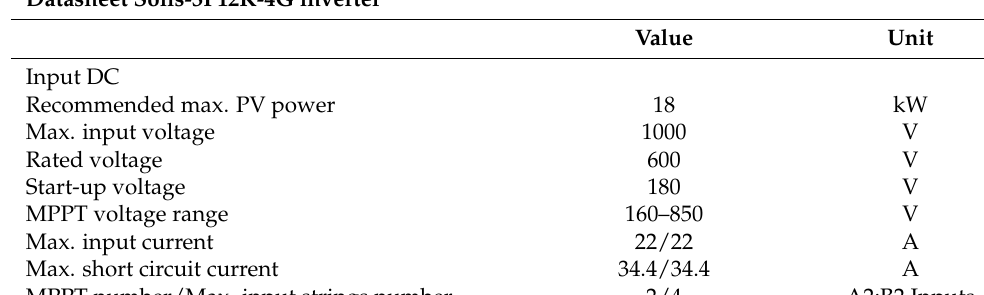
Table 5. Solis-3P12K-4G three-phase 220/380 VAC with two MPPT [81]. Datasheet Solis-3P12K-4G